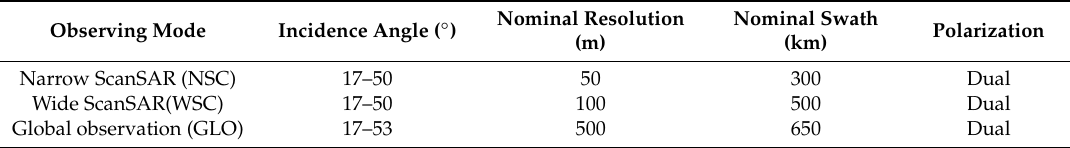
Table 1. Scanning synthetic aperture radar (ScanSAR) modes of GaoFen-3 (GF-3).